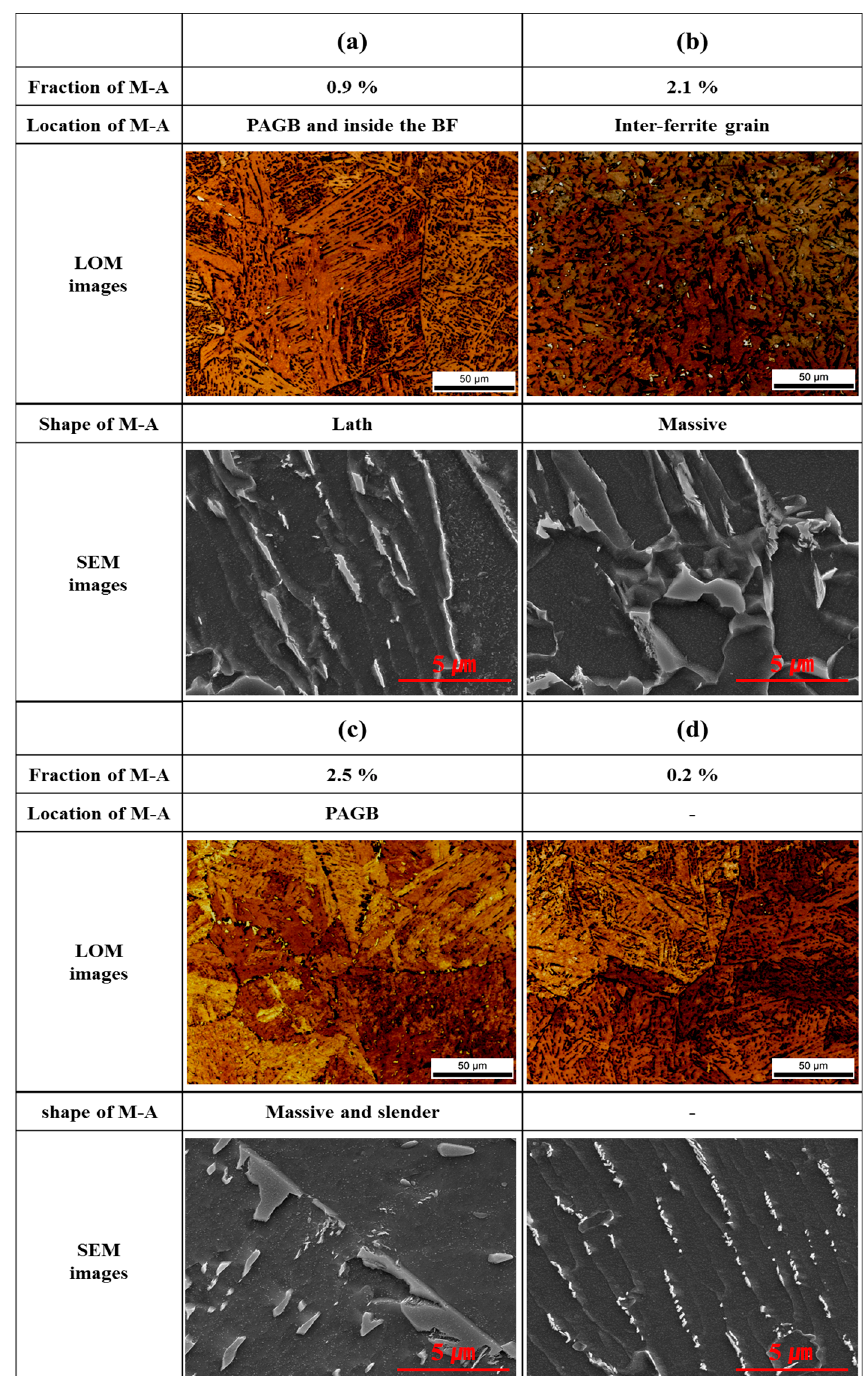
Figure 6. Microstructures of each simulated HAZs: ( a ) CGHAZ; ( b ) FGHAZ; ( c ) IRCGHAZ; and ( d ) SRCGHAZ.